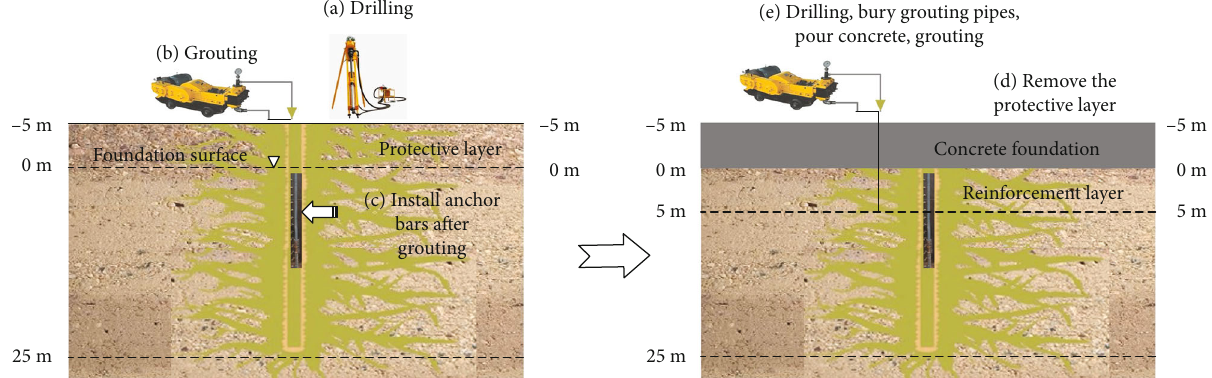
Figure 6: The overburden consolidation grouting processes.